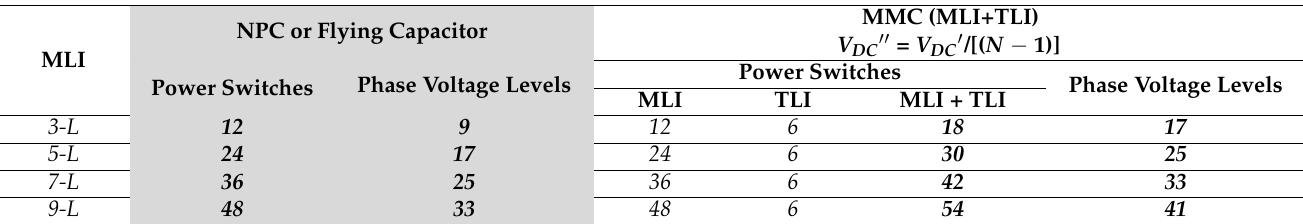
Table 1. Basic multi-level inverter (MLI) topologies vs. the asymmetrical hybrid multi-level inverter (AHMLI).